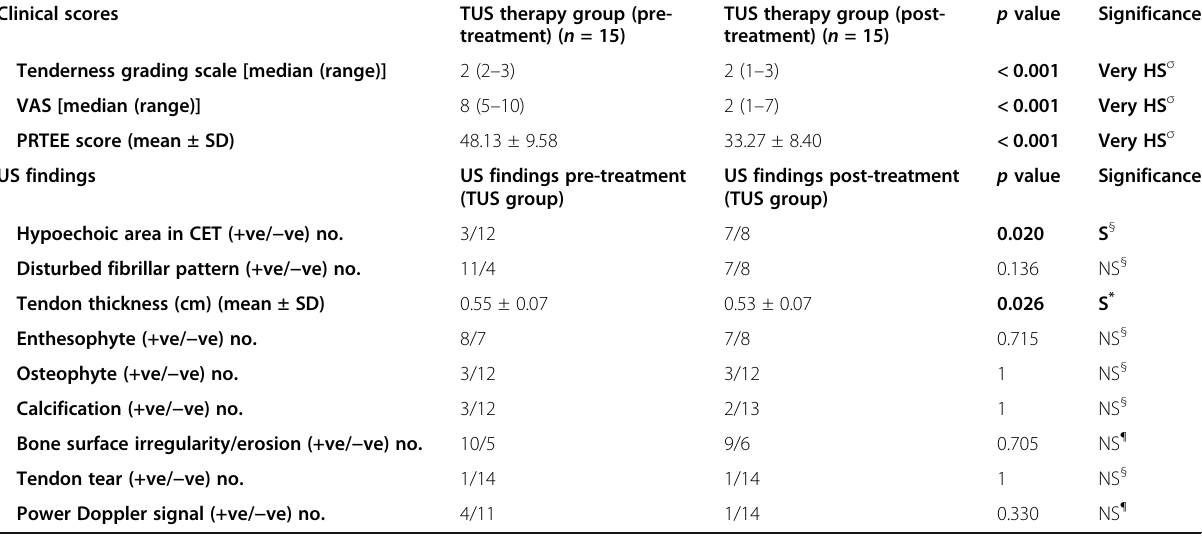
Table 4 Comparison of tenderness grading scale, pain intensity measured by VAS scale, PRTEE score, and US findings before and after treatment in TUS therapy group Clinical scores TUS therapy group (pre- treatment) ( n = 15)